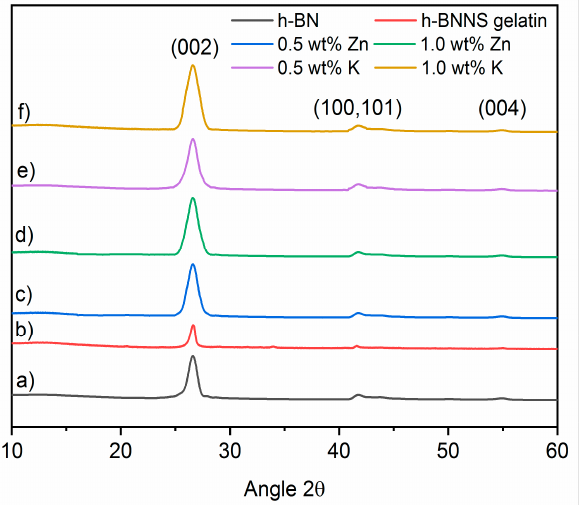
Figure 3. XRD patterns ( a ) pristine h-BN; ( b ) h-BNNS gelatin; ( c ) h-BNNS exfoliated by intercalation of 0.5 wt % ZnCl 2 ; ( d ) h-BNNS exfoliated by intercalation of 1.0 wt % ZnCl 2 ; ( e ) h-BNNS exfoliated by intercalation of 0.5 wt % KCl; and ( f ) h-BNNS exfoliated by intercalation of 1.0 wt % KCl.